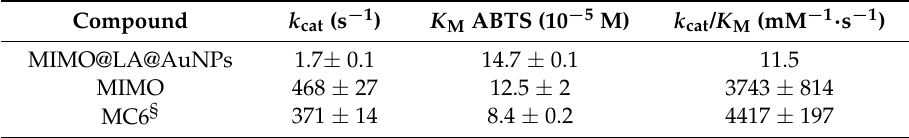
Table 1. Kinetic parameters for H 2 O 2 dependent oxidation of ABTS by MIMO@LA@AuNPs. The data for the free MIMO enzyme are also reported for comparison ( k cat : turnover frequency; K M : Michaelis–Menten constant; MC6: Fe(III)-Mimochrome